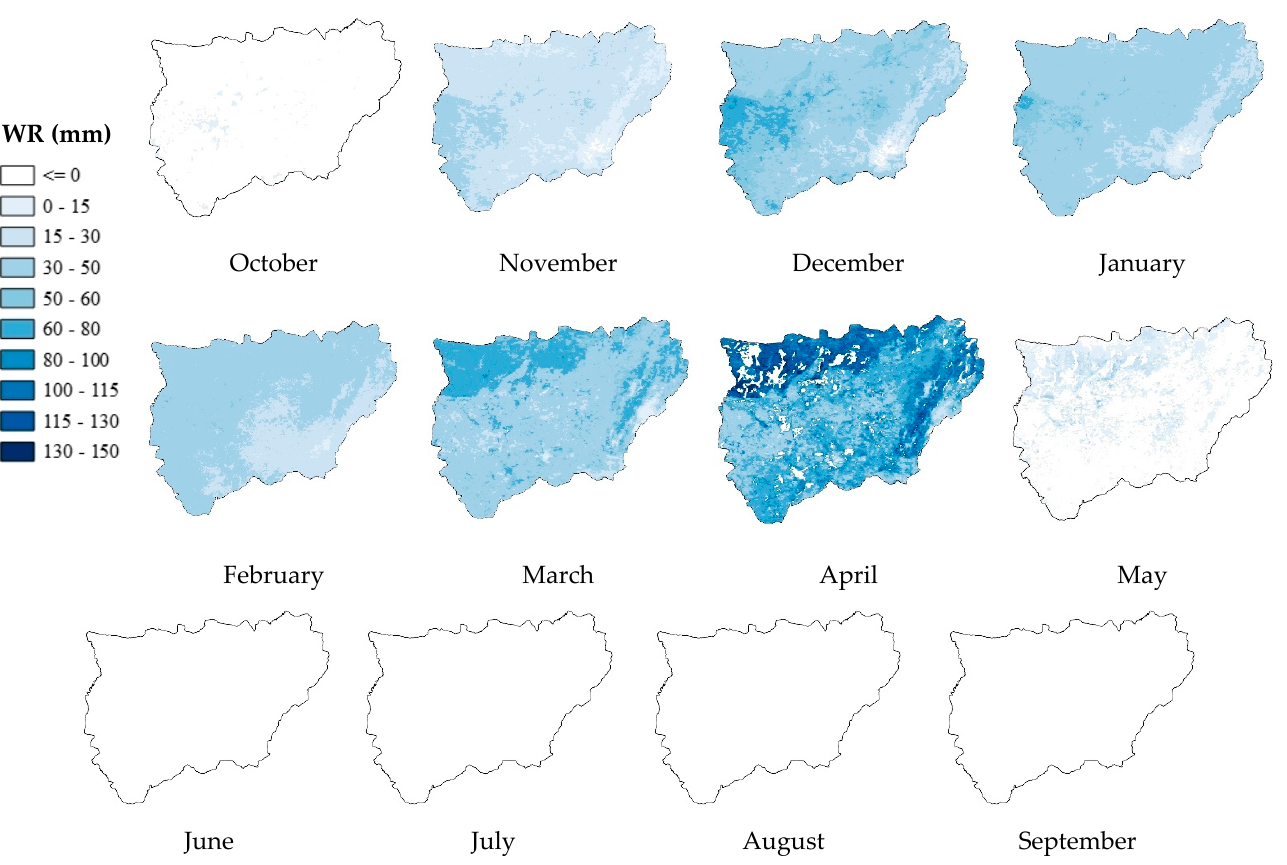
Figure 13. Monthly variation in soil water reserve. (WR is water reserve in the soil. The scale of color is presented on the left of the figure).